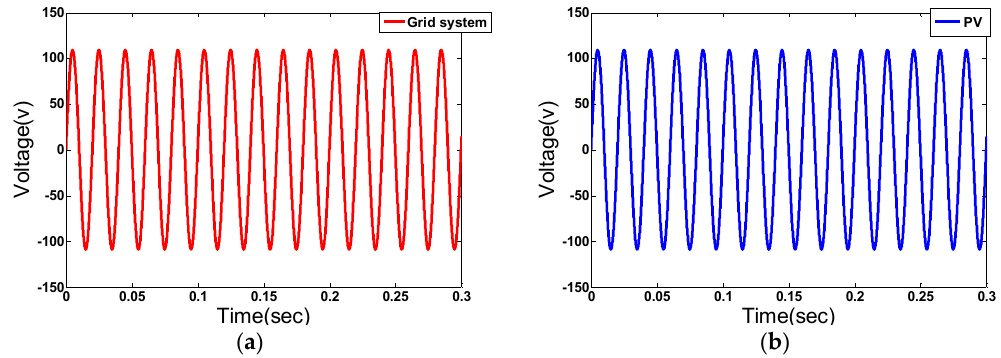
Figure 7. ( a , b ) Waveforms of generated solar power connected to the grid.